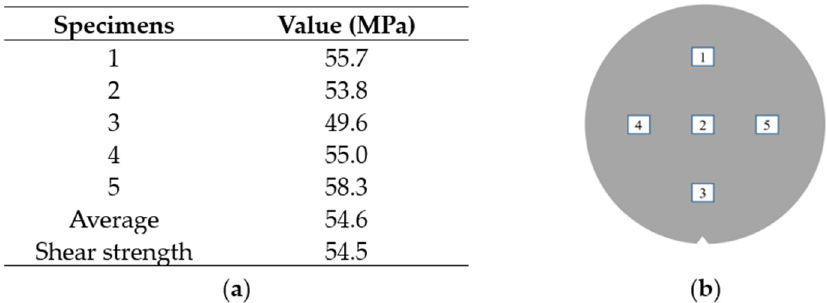
Figure 14. Shear strength test for RF filter WLP. ( a ) Shear force; ( b ) Measurement location.